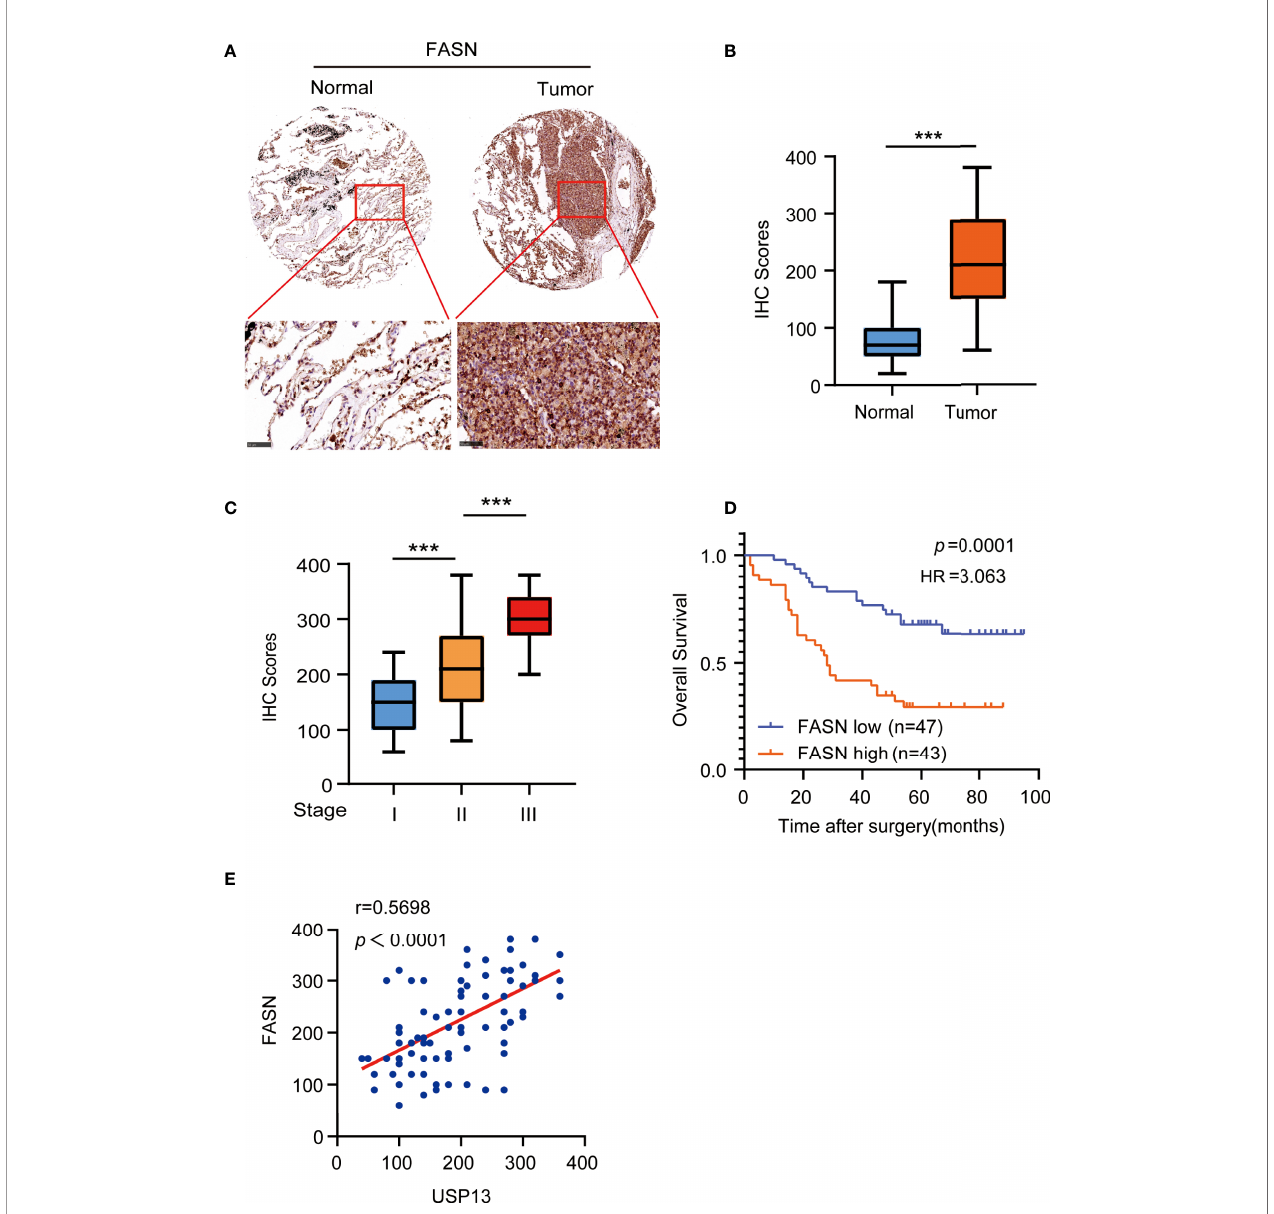
FIGURE 5 | FASN is positively correlates with USP13. (A, B) Representative images (A) of IHC staining for FASN protein on tissue microarray (TMA) composed of SCLC tumor specimens (T) with their adjacent normal tissues (N). IHC score (B) was calculated. Scale bars: 100 m m. Data represent the means ± SD of samples. Two-tailed student ’ s t-test was used. *** p < 0.001. (C) FASN expression levels are shown in SCLC patients of different cancer stages. Data represent the means ± SD of samples. Two-tailed student ’ s t-test was used. *** p < 0.001. (D) Kaplan-Meier plots of the overall survival time of 90 SCLC patients with low or high expression levels of FASN. p values are calculated using a log-rank test (two-tailed). (E) The correlation between USP13 and FASN expression in an SCLC tissue microarray was analyzed using a two-tailed Pearson correlation coef fi